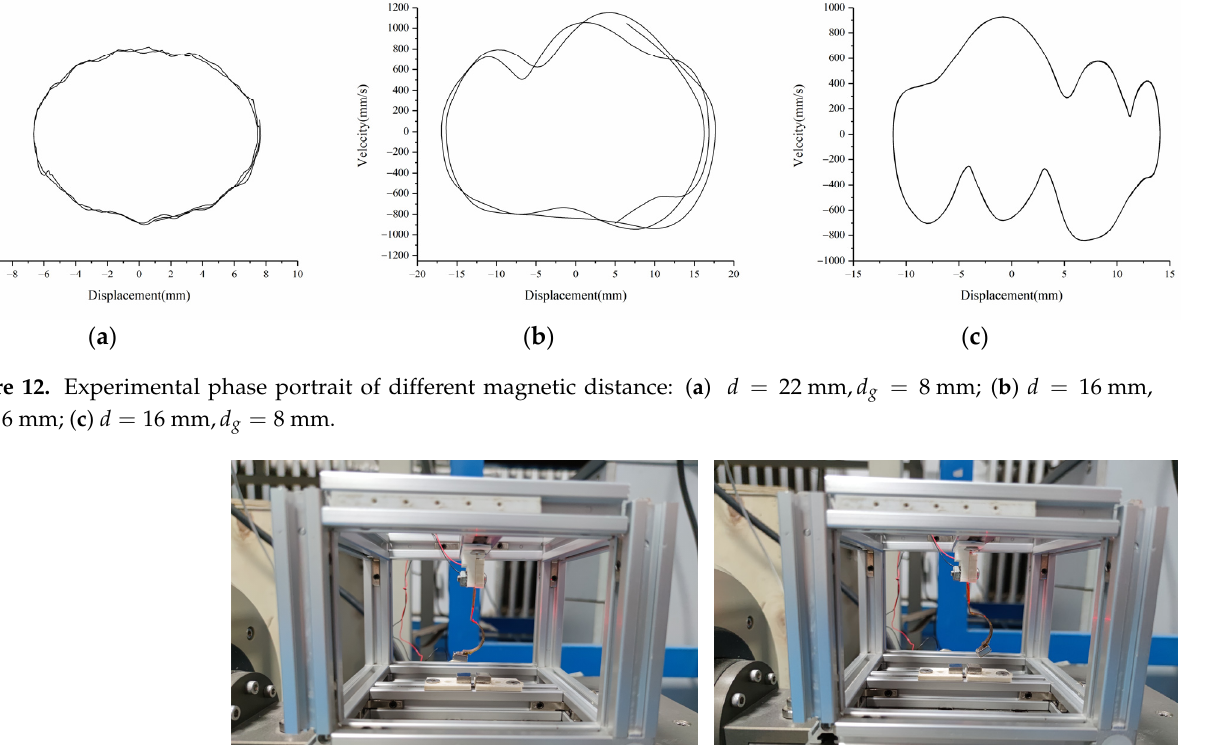
Figure 11. Three stable equilibrium positions: ( a ) stable1; ( b ) stable2; ( c ) stable3.